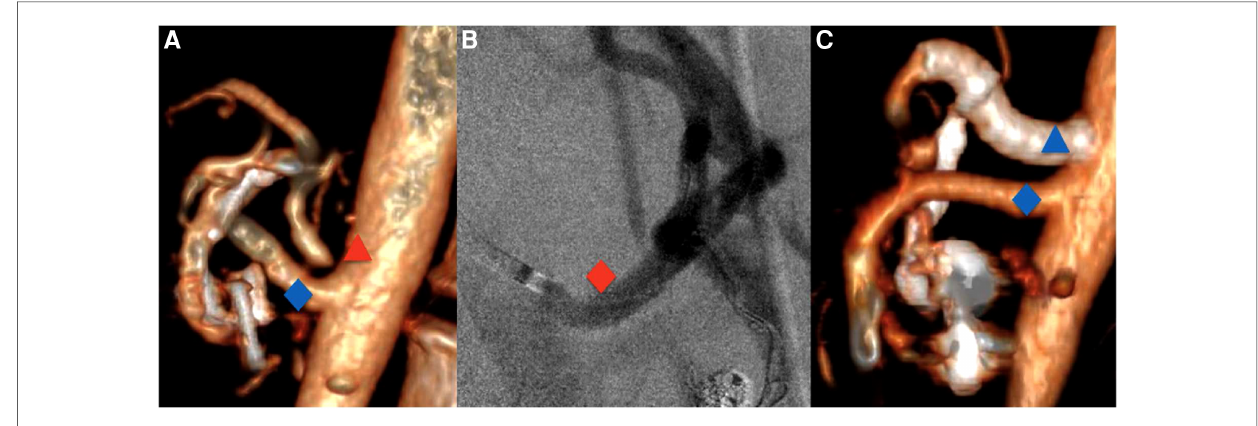
FIGURE 1 ( A ) Preoperative 3D computed tomography with the CT stenosis (red triangle) and the patent SMA (blue diamond). ( B ) Perioperative CT arteriography after stenting (red diamond). ( C ) Postoperative 3D computed tomography with the patent CT stents (blue triangle) and SMA (blue diamond). CT, celiac trunk; SMA, superior mesenteric